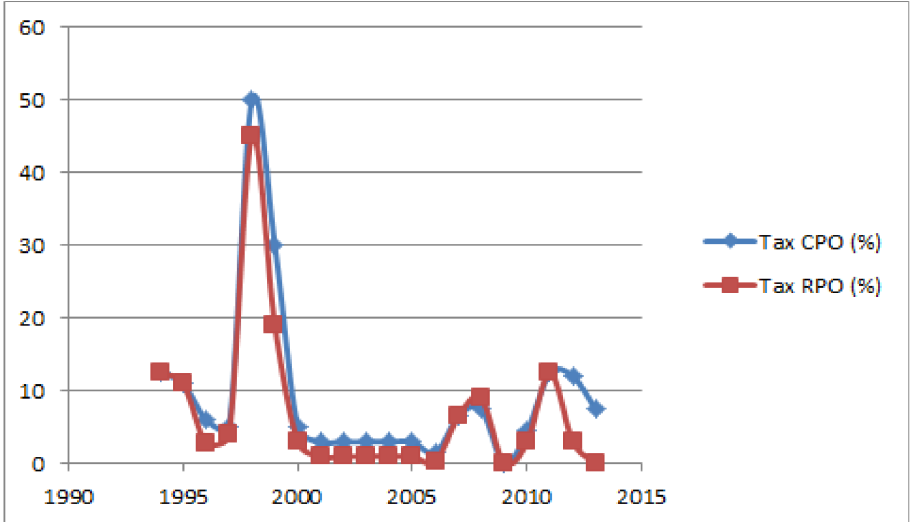
Figure 7. Effective Export Tax of CPO and RPO